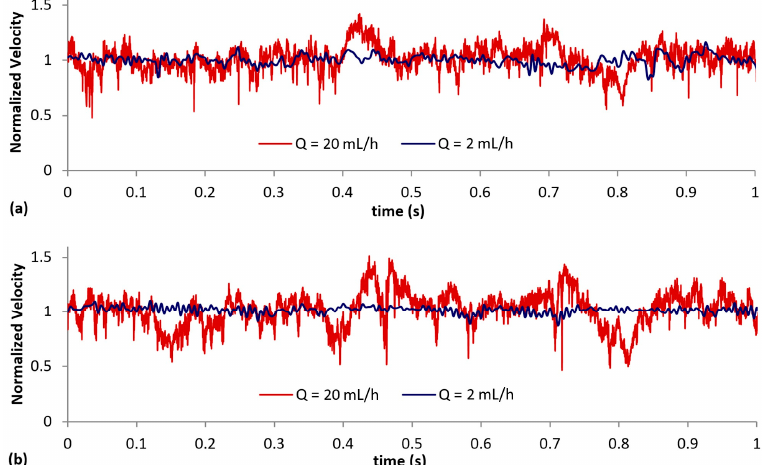
Figure 11. Normalized low frequency axial velocity measurements at ( a ) interrogation window A ( δ = 0.3 mm) and ( b ) interrogation window B ( δ = 1.0 mm) obtained using recording mode 1.